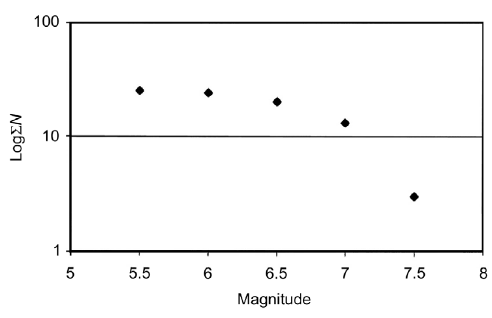
Fig. 24. The completeness plot of the parametric catalogue ( N : number of